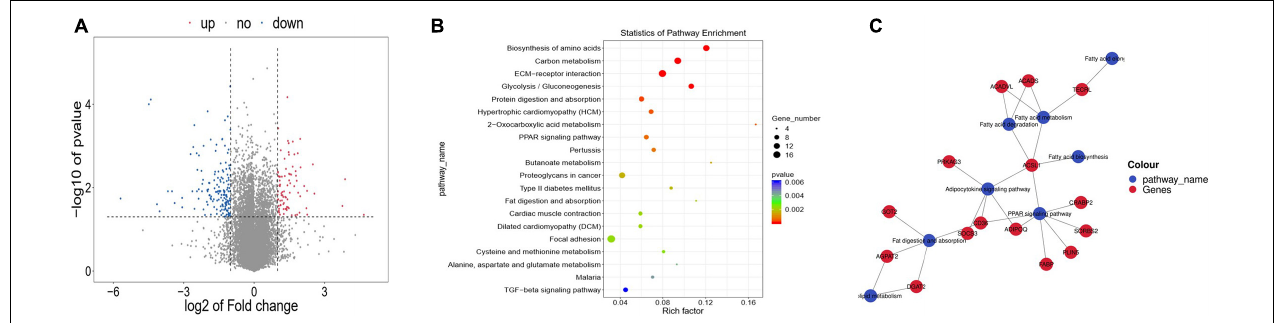
FIGURE 2 | Differentially expressed genes (DEGs) in skeletal muscle in the high-fatty acid group and the low-fatty acid group. (A) DEGs. The red and blue dots represent upregulated and downregulated mRNAs, respectively. (B) KEGG pathway analysis for the DEGs. Only the top 20 enriched pathways are presented here. (C) KEGG-DEGs pairs and regulatory network.